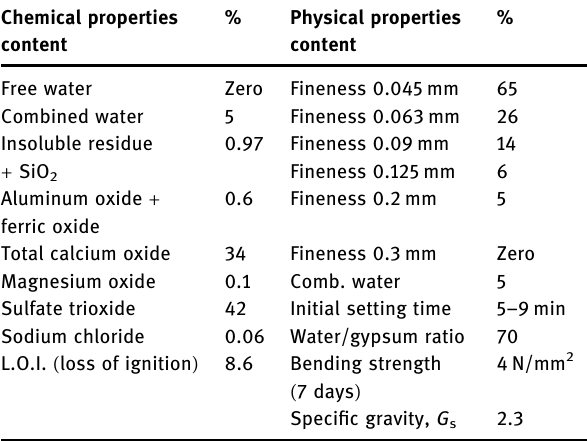
Figure 1: Setup of the laboratory footing model.